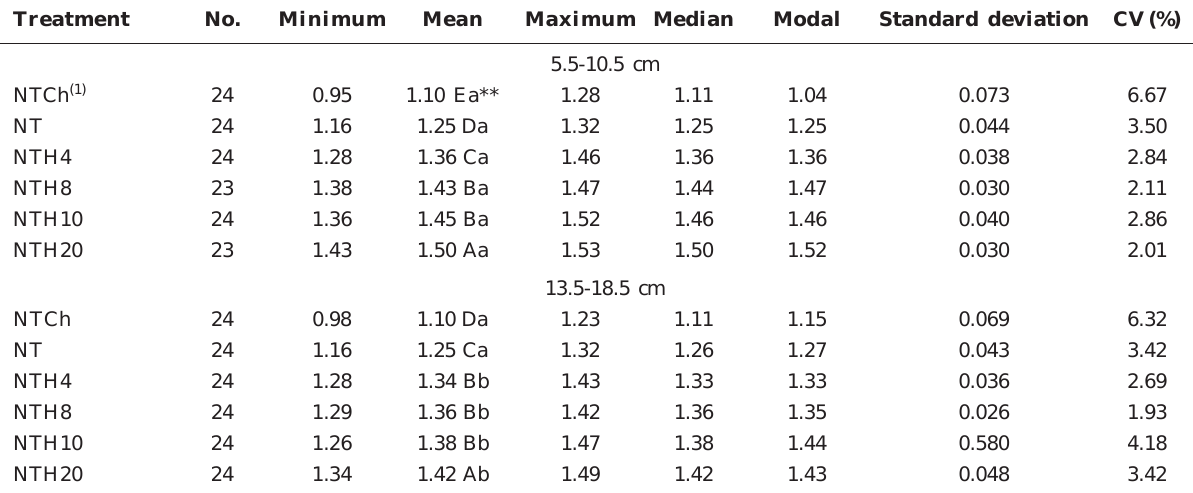
Table 2. Descriptive statistics for the soil bulk density of a Rhodic Eutrudox, assessed at different compaction levels and in two soil